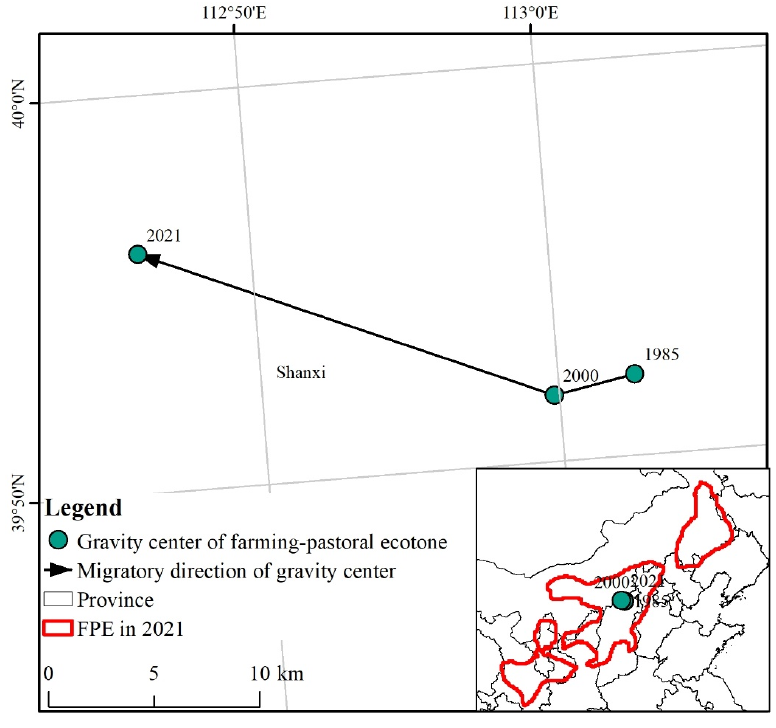
Figure 4. Gravity center of the FPE in 1985, 2000, and 2021.